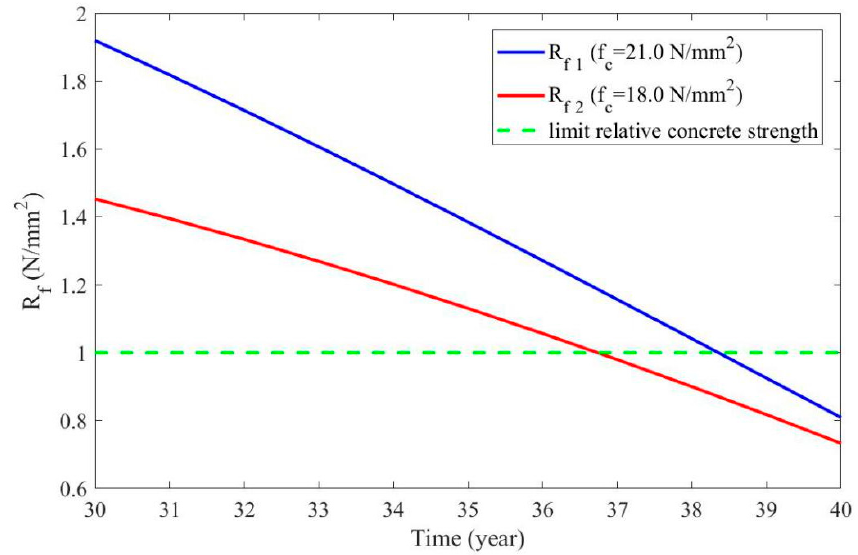
f and 2 N/mm 21.0= f ). Figure 20. Relative equivalent design concrete strength ( f c = 18.0 N/mm 2 and f c = 21.0 N/mm 2 c c